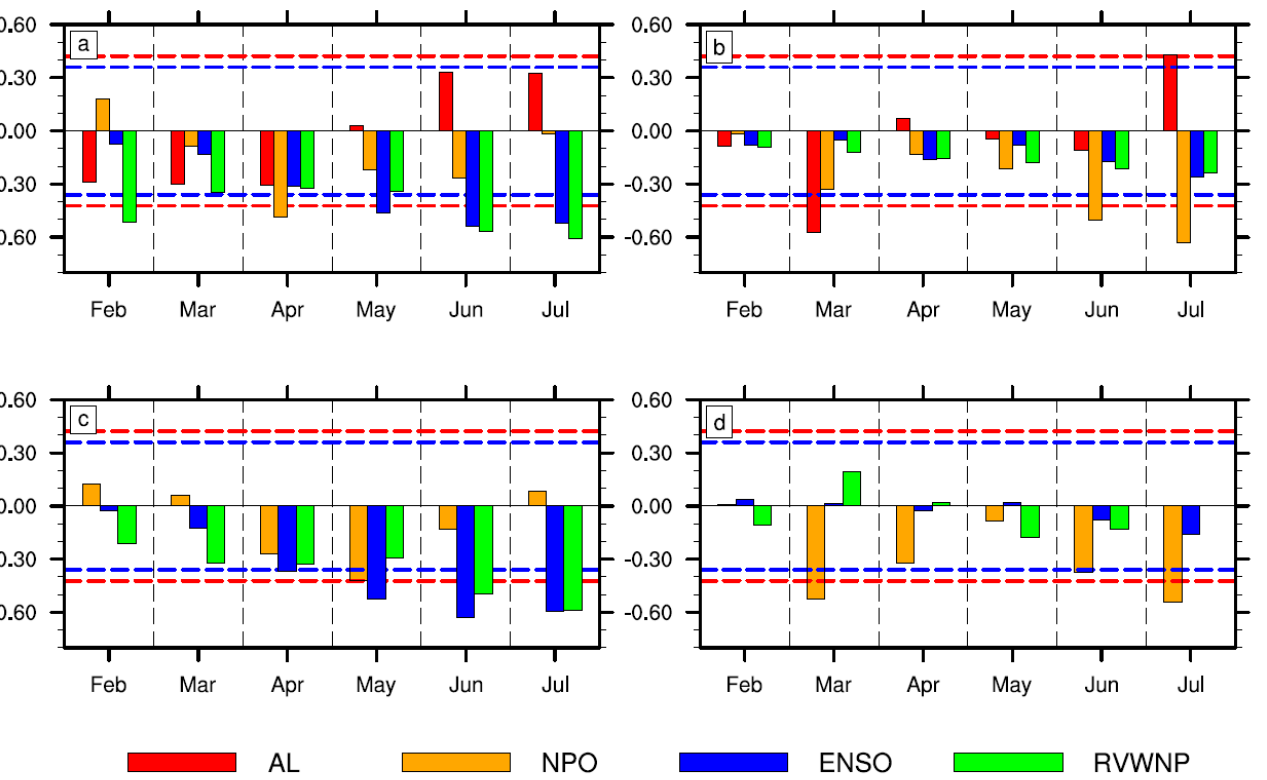
Figure 7. ( a , b ) Lag correlation coefficients between the JFM SH index and the AL (red), NPO (orange), Nino3.4 (blue), RVWNP (green) indices and ( c , d ) partial correlations coefficients after linearly removing the influence of EAWM during ( a , c ) 1980–2002 and ( b , d ) 2003–2020. The RVWNP index is defined as the regional mean 850 hPa relative vorticity anomaly in the West North Pacific (5 ◦ N–20 ◦ N, 130 ◦ E–180 ◦ ). The horizontal axis represents the target month of used indices. The blue (red) dashed lines indicate the correlation coefficient significant at 90% (95%) confidence level based on the two-sided Student’s t -test.